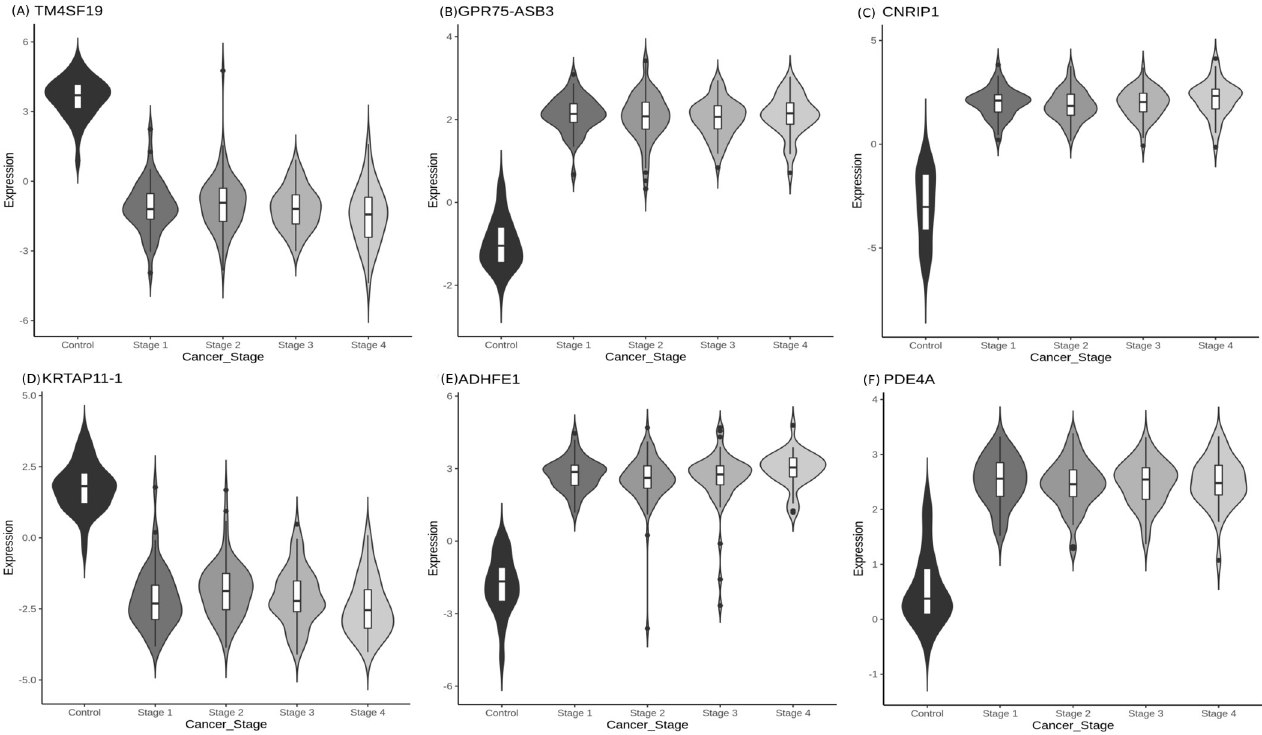
Fig 2. Top DMGs identified from linear modelling. (A) GPR75-ASB3, (B) TM4SF19, (C) CNRIP1, (D) KRTAP11-1, (E) ADHFE1 and (F) PDE4A. For each gene, notice that the trend in methylation could be either hyper-or hypo-methylation relative to the control. TM4SF19 and KRTAP11-1 are hypomethylated whereas CNRIP1, GPR75-ASB3, ADHFE1, PDE4A are hypermethylated.